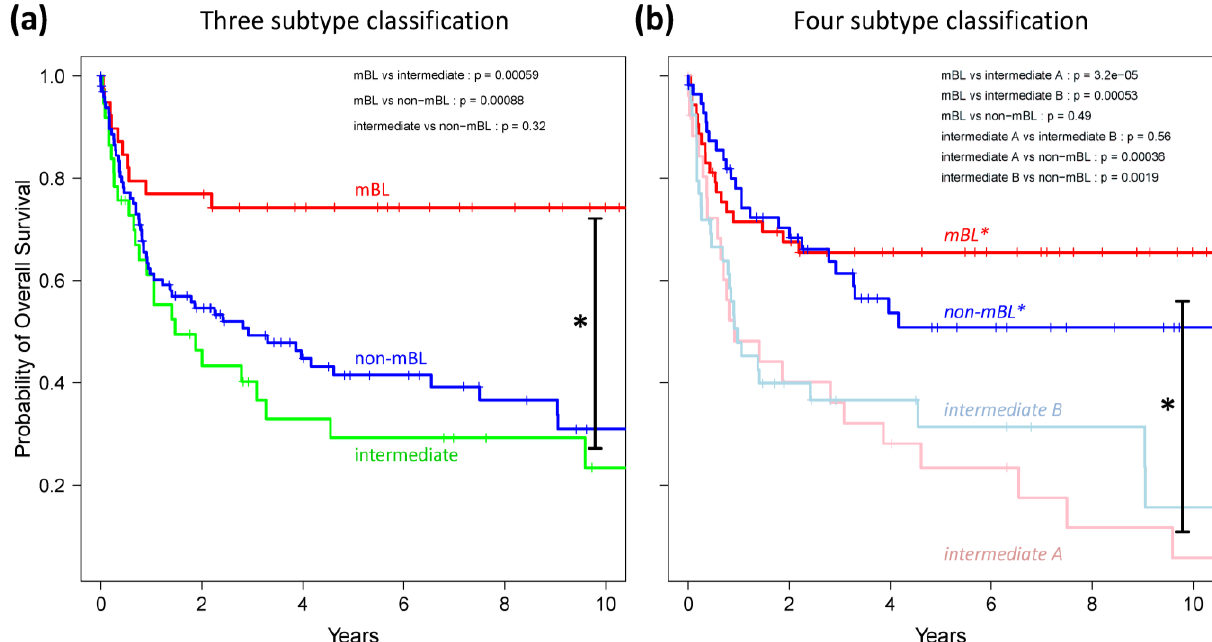
Figure 9. Kaplan-Meier survival curves of the original three subtypes ( a ) and the new four subtype ( b ) classifications. Tick marks indicate patients alive at the time of last follow-up. Subtype specific survival curves are compared using log-rank test and the respective p- values are indicated within the